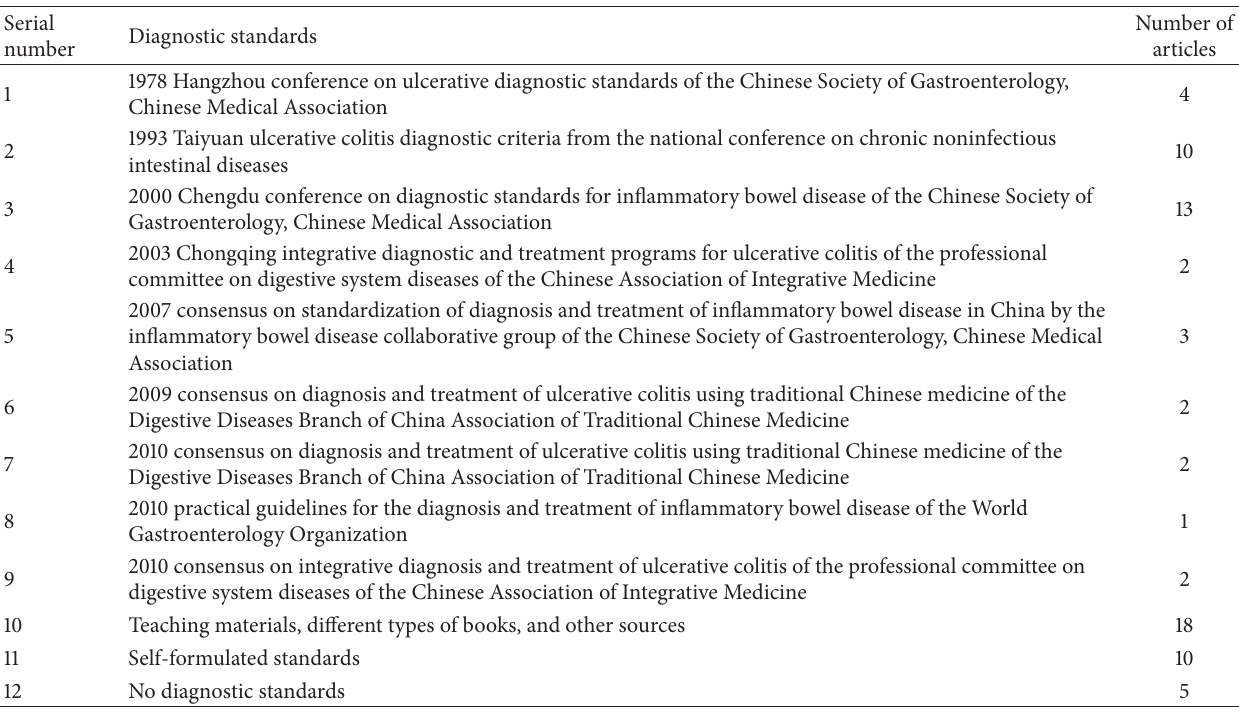
Table 1: The use of diagnostic standards.